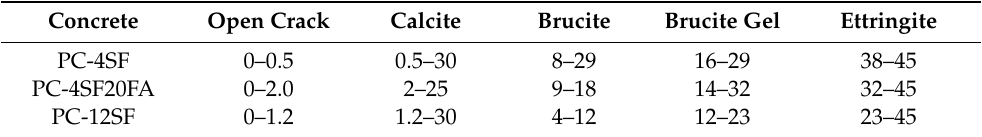
Table 9. Variation of mineralogy of self-healing products with crack depth in mm.